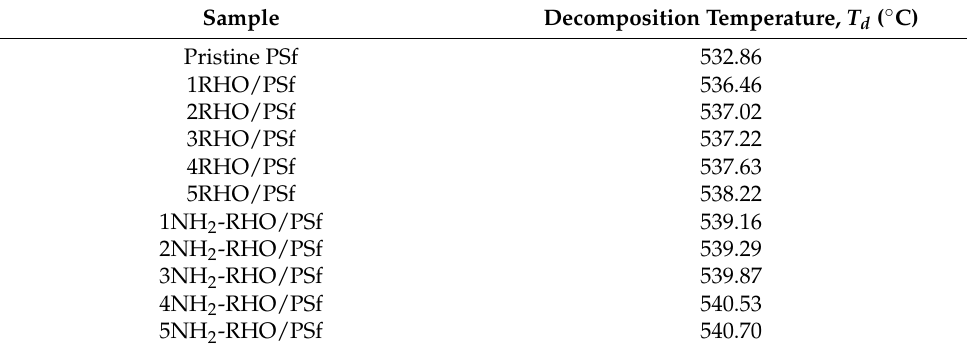
Figure 9. DTG thermograms of pristine PSf membrane, 5RHO/PSf, and 5NH 2 -RHO/PSf MMMs. Table 2. Decomposition temperature of pristine PSf membrane and